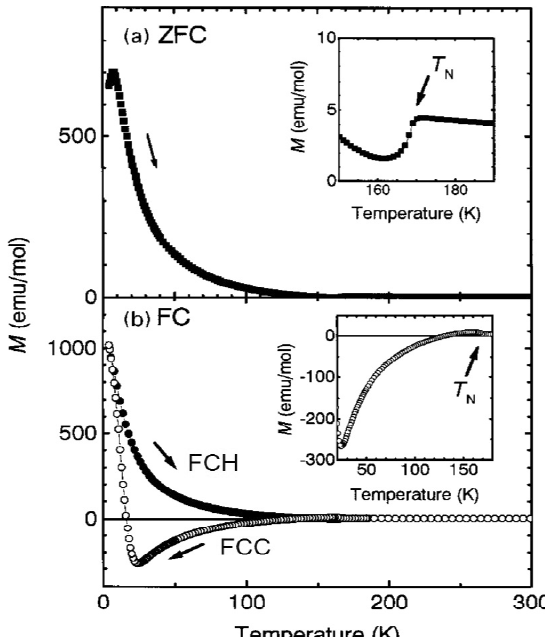
Fig. 2 . (a) ZFC and (b) FC temperature dependent magnetization curve (M T) curves for GdCrO3 with an applied Field of H =100 Oe. Reproduced from [1] with the permission from Elsevier.